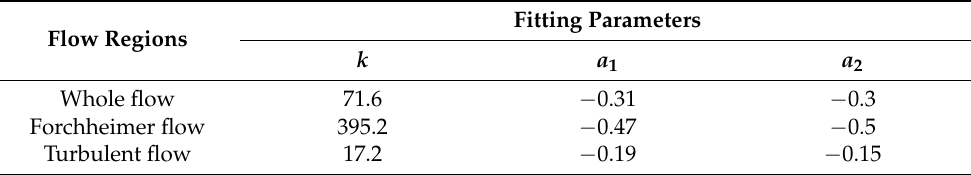
Fitting Parameters